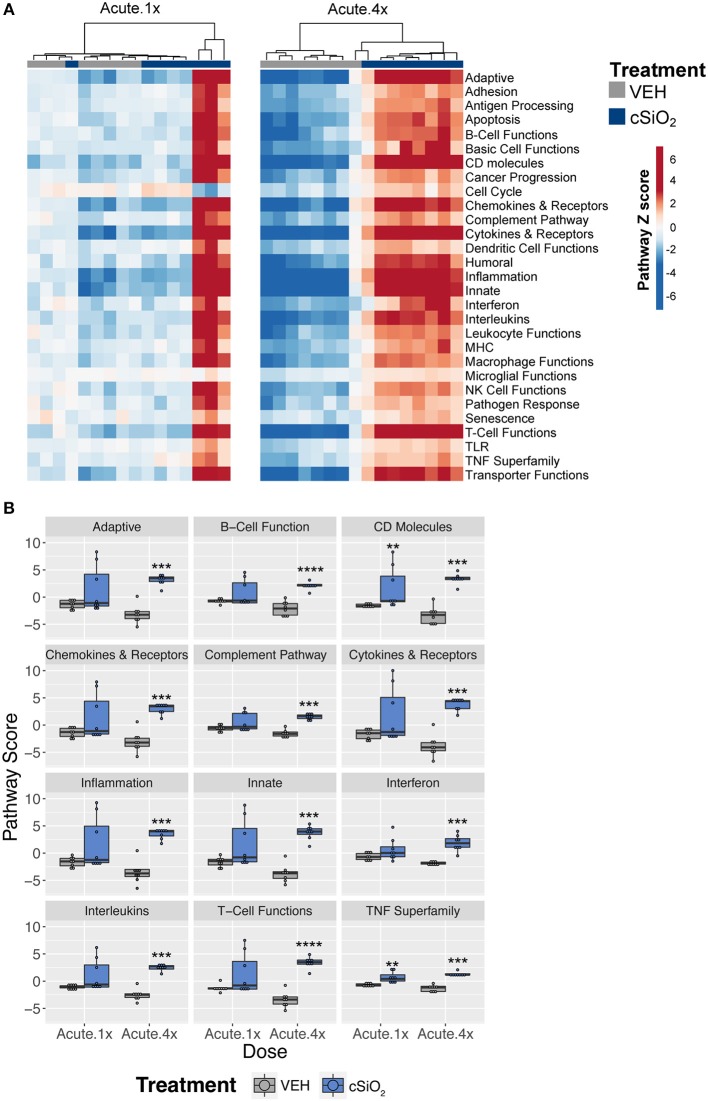
Lung tissue gene expression pathway Z scores for mice that received either a single or four weekly instillations of cSiO2. (A) Heatmap depicts individual pathway Z scores of each immune pathway for lung tissues obtained from vehicle (VEH) or cSiO2-treated mice following a single (Acute.1x) or four weekly (Acute.4x) instillations. (B) Pathway Z scores are presented as Tukey box-plots (n = 8) for select immune pathways of interest. **p < 0.01; ***p < 0.001, and ****p < 0.0001 compared to dosing-matched vehicle control as determined by the non-parametric Wilcoxon test.